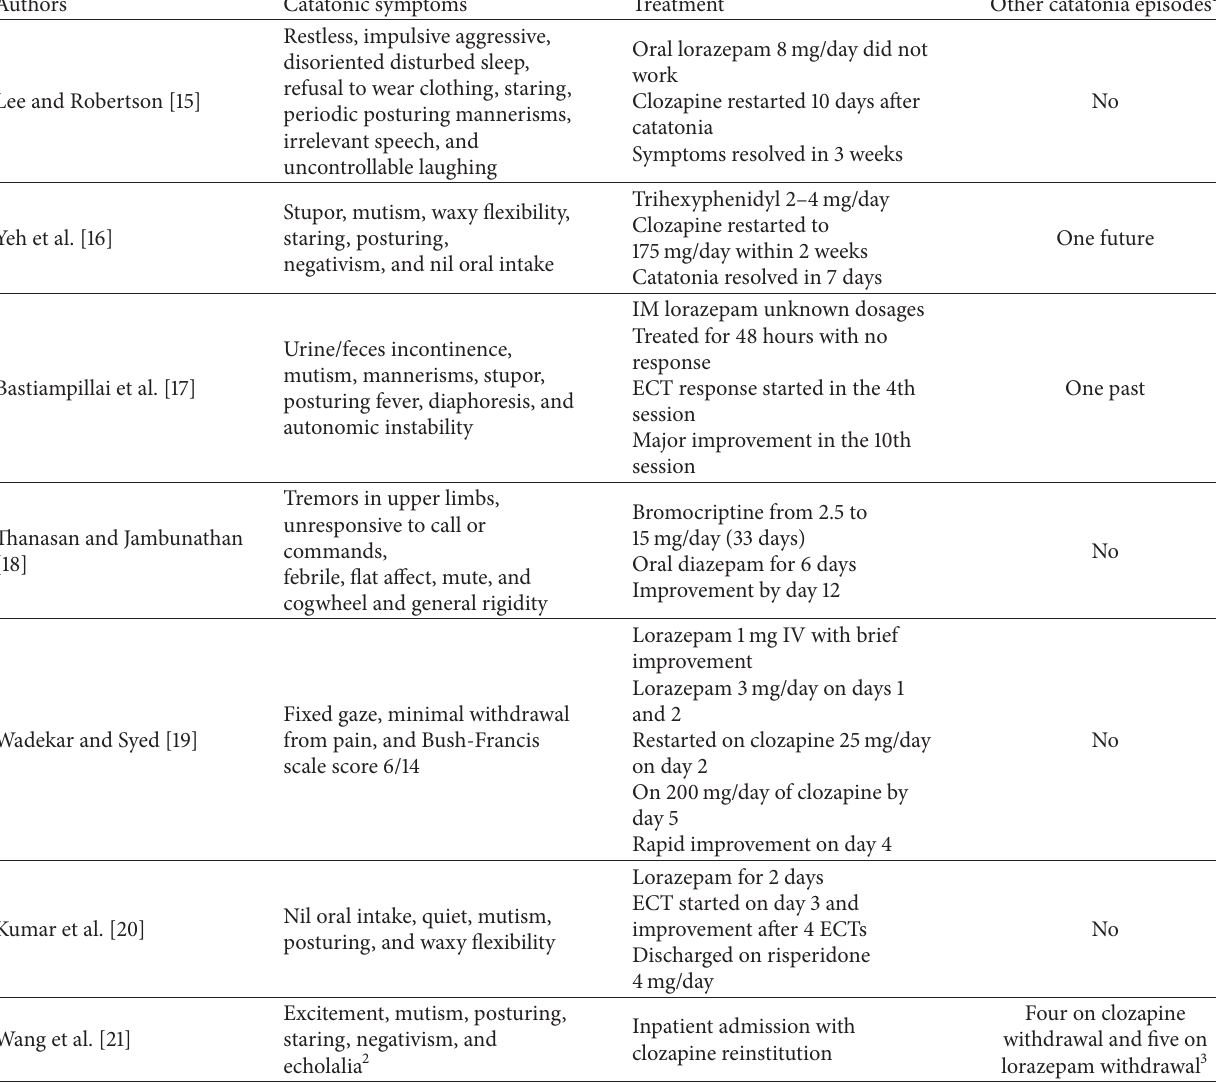
Table 2: Details for 7 cases which were considered at least probable catatonic episodes secondary to clozapine withdrawal.